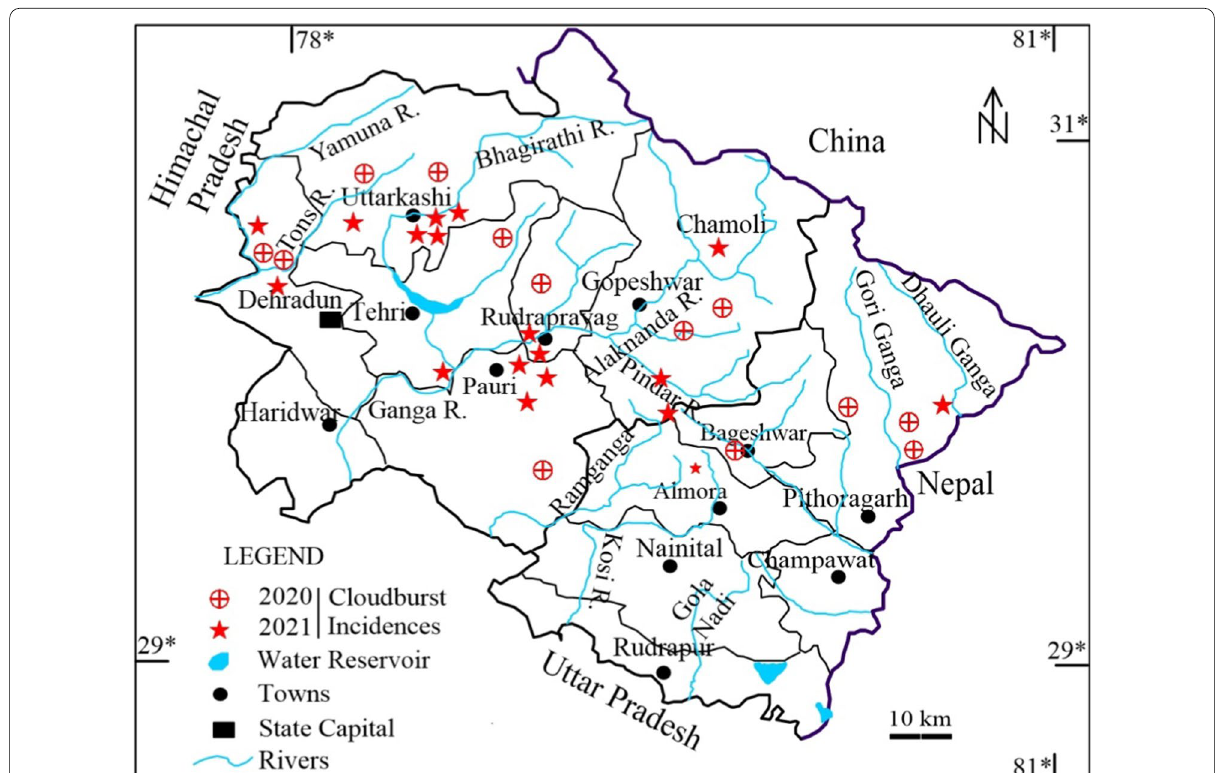
Fig. 4 Location map of cloudbursts hit areas in 2020 and